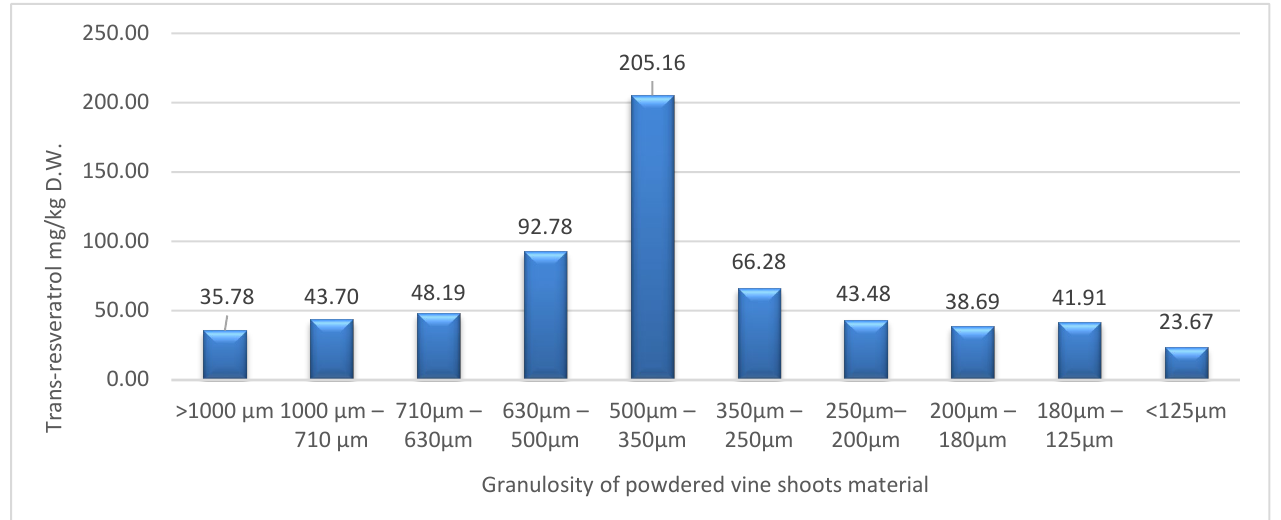
Figure 3. Extraction yield of resveratrol from vine shoots for different time of maceration.